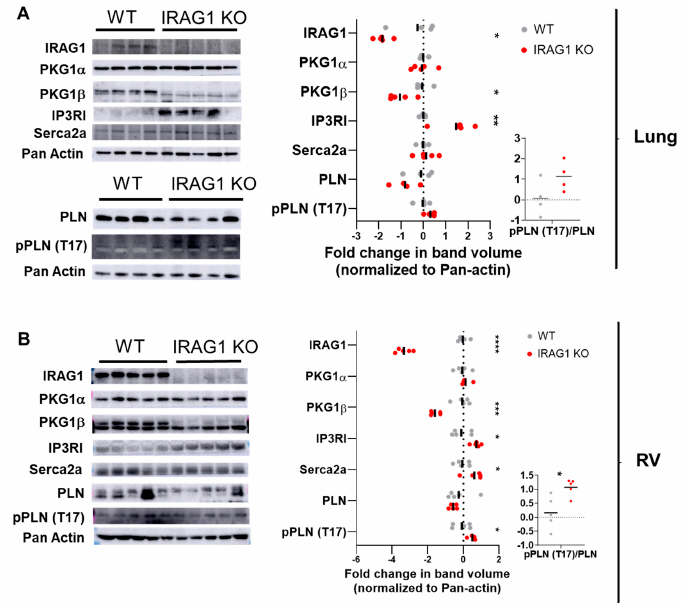
Figure 5. IRAG1-deficient mice had endogenous dysregulation of PKGI β in lung and RV ( A , B ) Western blots of protein lysates isolated from WT and IRAG1 KO mice lungs ( A ) and right ventricles ( B ). Representative blot pictures are on the left and subsequent lognormal values of densitometry quantifications are on the right. Densitometry was performed in the same blot pictures as presented here and n number corresponds to different animals in the same experiment. Number of animals used: ( A ) Lungs from four WT and five IRAG1 KO mice; lungs from four WT and four IRAG1 KO mice for PLN and Ppln (T17); ( B ) right ventricles from five WT and five IRAG1 KO mice. Primary antibodies used in western blots were IRAG1, PKG1 α , PKG1 β , IP 3 RI, Serca2a, Phospholamban (PLN), and phospho-Thr 17 Phospholamban [pPLN (T17)]. Pan-actin was used as housekeeping gene. Fold change was calculated in relation to normoxic controls. All the western blot data were represented as individual point and bar indicates the mean, * p < 0.05, ** p < 0.01, *** p < 0.001, **** p < 0.0001, two- tailed unpaired t -Test.